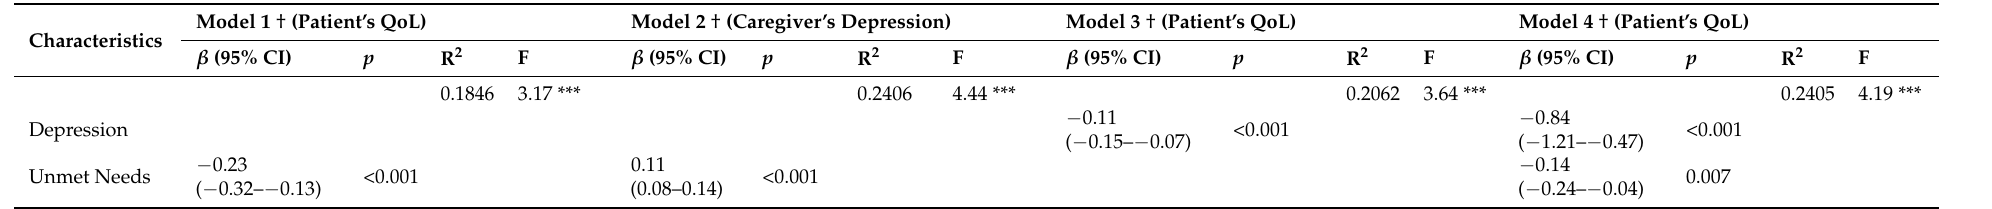
Table 4. Multiple linear regression models among the unmet needs and depression of caregivers and the QoL of care recipients (N =